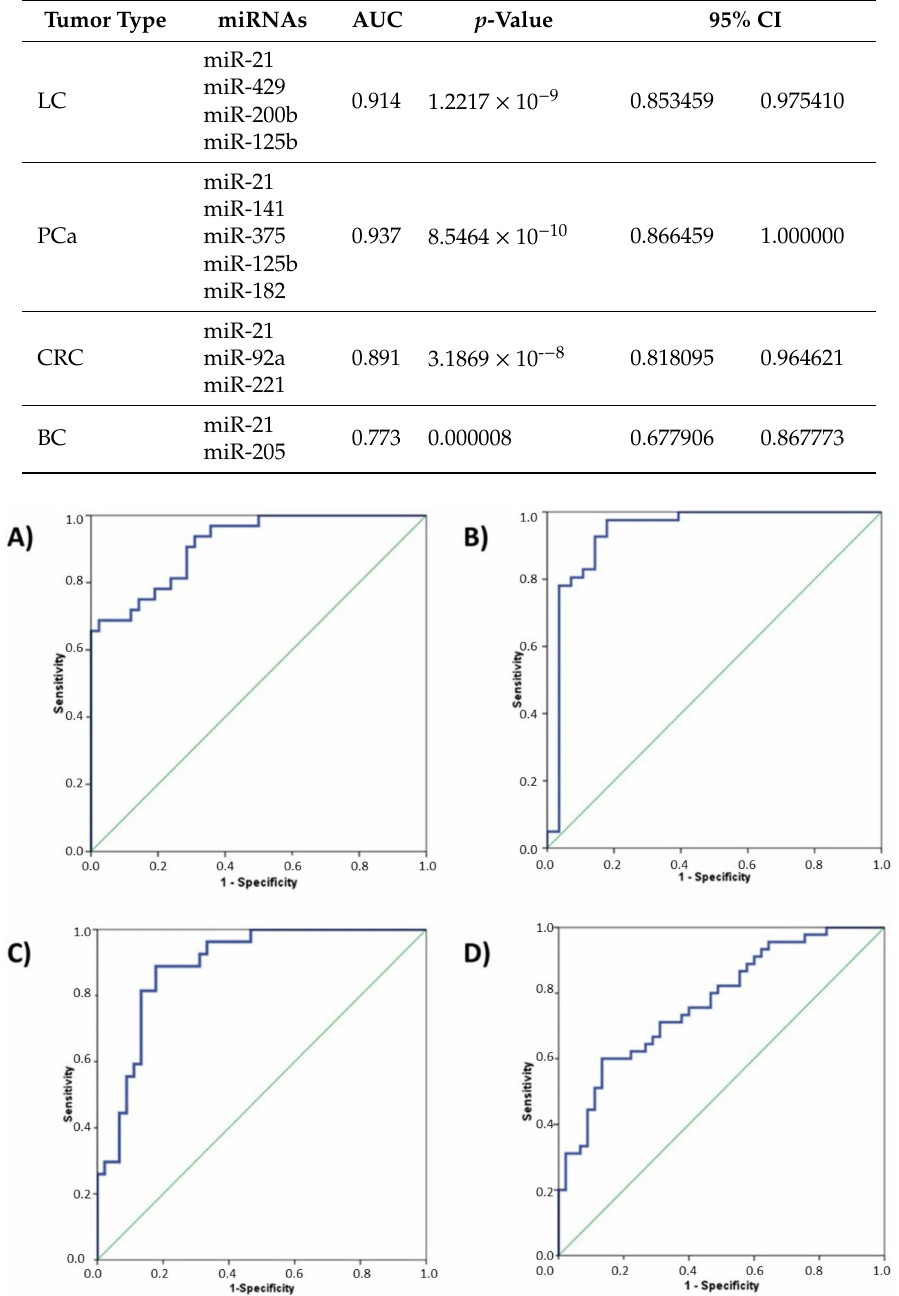
Table 2. Performance of a tetra-panel of circulating miRNAs in identifying cancer patients.